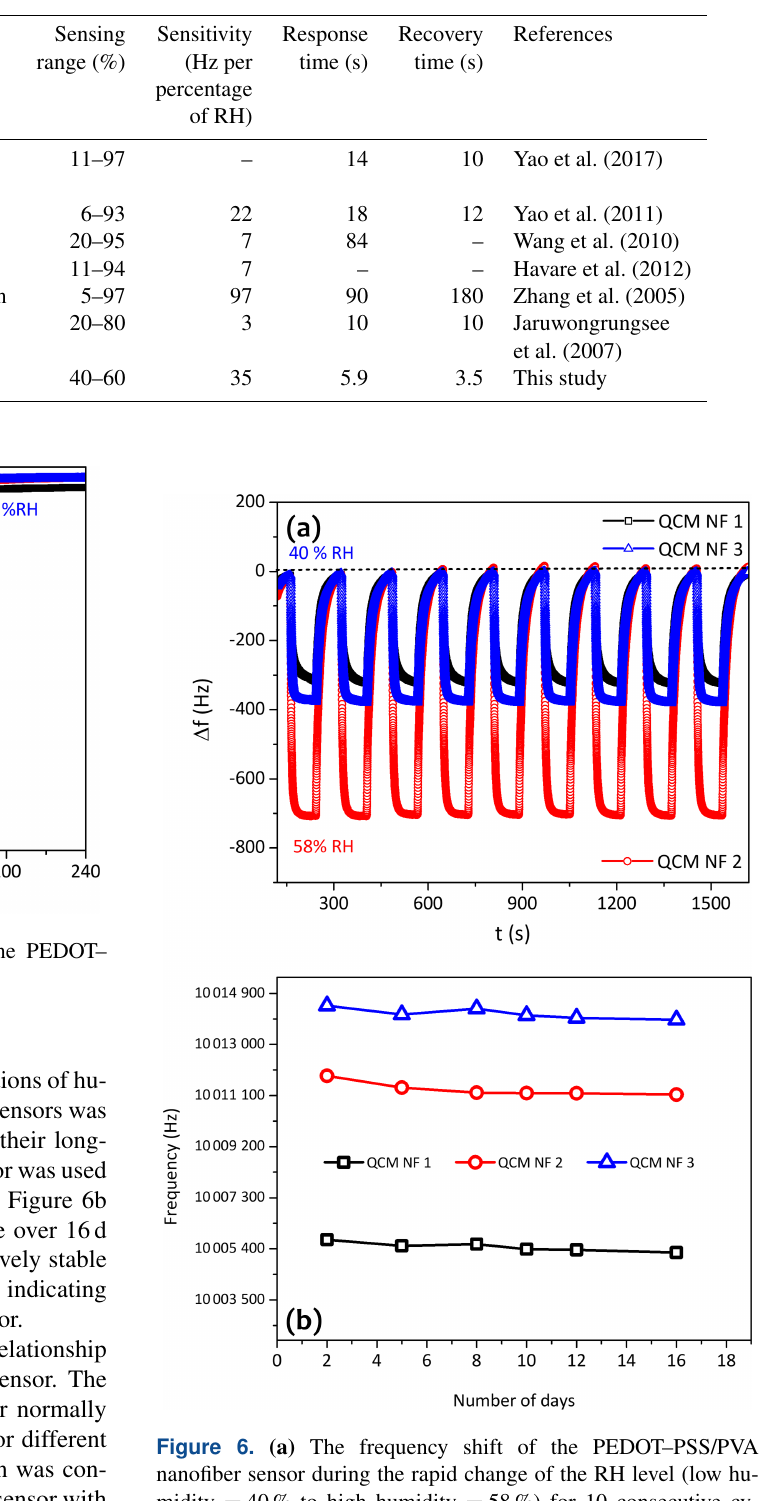
Table 2. Performance comparison of various humidity sensors based on the QCM.